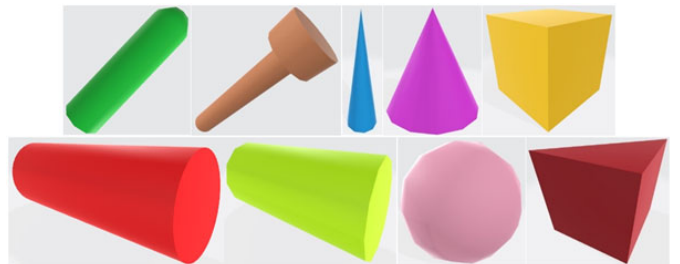
Fig. 10. Pieces (1 to 9 from left to right, from top to bottom) of the data set GP08 from Gogate and Pande (2008)